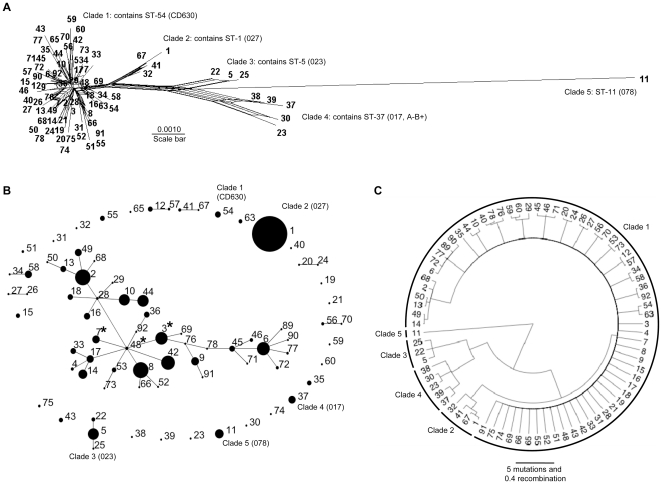
The C. difficile population is comprised of five clades with evidence of recombination within and among groups.(A) Phylogenetic network to illustrate relationships among 78 STs comprising the five clades. The networks were constructed using concatenated MLST loci and the program Neighbour-Net [44]. The clades containing well characterised isolates or genotypes, their ribotypes and STs are indicated (ST-89 was excluded as it differs from ST-6 by a single nucleotide deletion in the sodA locus only). (B) eBURST diagram to show the relationships among STs based on alleleic profiles [45]. Circle size for each of the 69 STs identified in the clinical isolate collection (total n = 1290) is proportional to the number of isolates. For completeness, one example of eight additional previously described STs (ST-20, ST-27, ST-29, ST-32, ST-38, ST-39, ST-40, ST-69) [22], and one (ST-30) identified in a separate study of infants were included to demonstrate their relationship to other members of the population. Well characterised representatives of each clade are indicated as in (A). STs identified in both toxigenic and non-toxigenic form are indicated by a star. (C) ClonalFrame analysis [46]. The five clades are indicated and branch lengths are measured in expected number of mutation and recombination events.